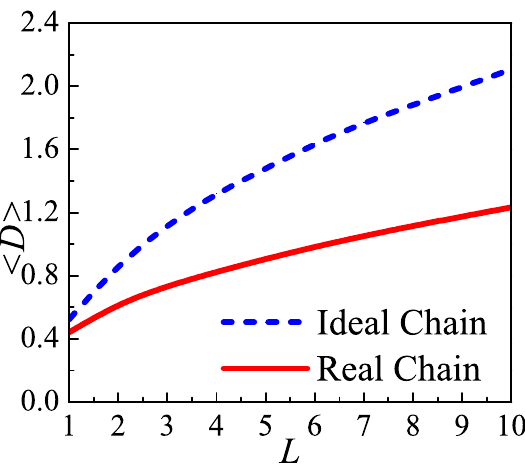
Figure 9. The optimal average distance between two injection points of loop versus its length for ideal/real chain. The blue dash line and red solid line correspond to ideal chain and real chain,